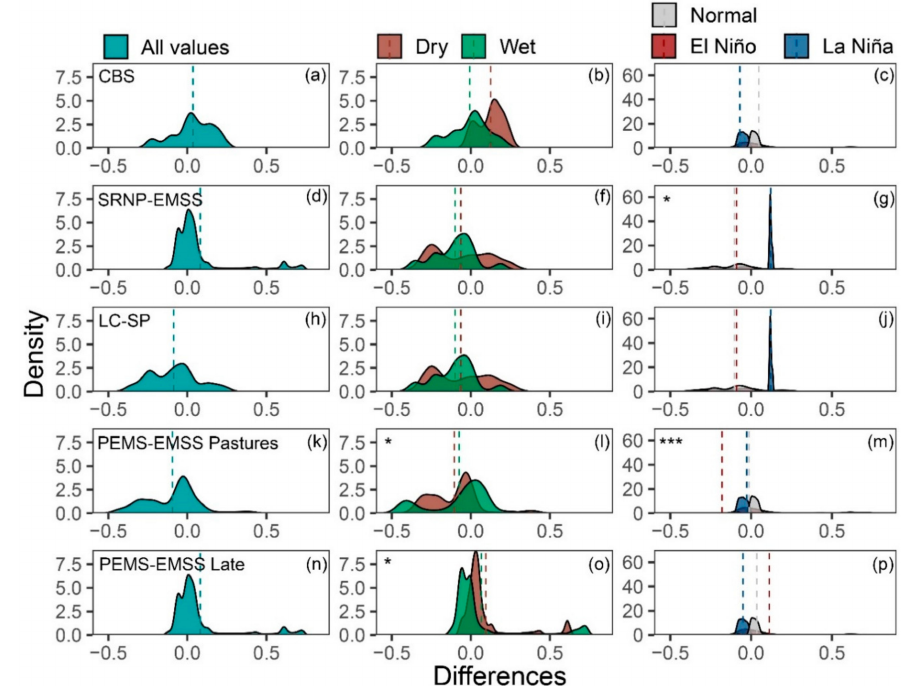
Figure 4. Density distribution of the di ff erences comparing standardized NDVI derived from near-surface and PROBA-V observations in di ff erent seasons (wet and dry season) and ENSO events at four tropical dry forests. Density curves were created using a Gaussian distribution with a bandwidth of 5. Vertical dotted lines represent the mean value of the overall errors per category. Asterisks indicate the significant di ff erences of generalized least squares models between seasons or ENSO months (See Table 3 for detailed representation), as follows: * p < 0.05; ** p < 0.01; *** p < 0.001. Table 3. Results of the linear model using generalized least squares comparing the temporal and seasonal or ENSO e ff ects (independent factors) on the variation of the di ff erences of standardized NDVI between near-surface and satellite observations (MODIS and PROBA-V) at four tropical dry